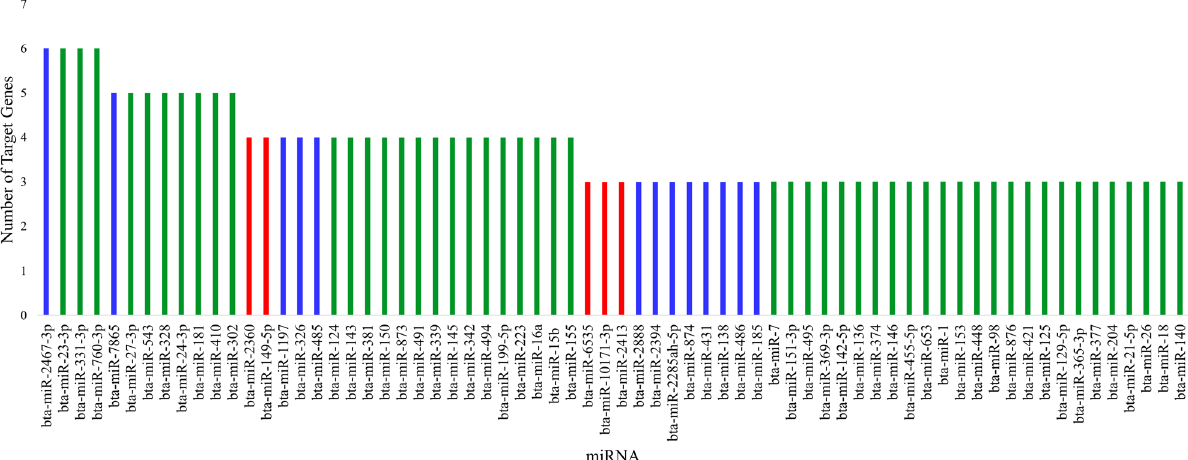
Figure 4. miRNA predicted to bind to three or more target genes. The red bars are miRNA predicted to bind to 3 ′ UTR, CDS, and 5 ′ UTR. The blue bars represent miRNA binding to two of the three regions. The green bars are miRNA predicted to bind to one of the three regions. Figure created with Microsoft Excel (2013) (https:// www. micro soft. com/ en- us/ micro soft- 365/ excel).